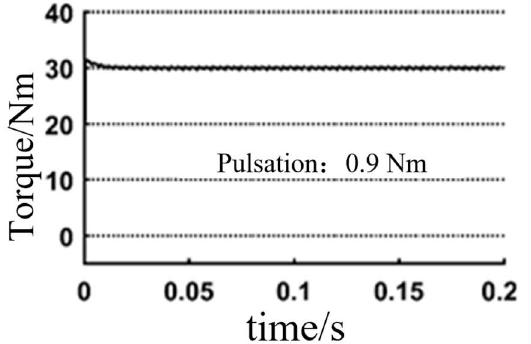
Figure 6. Simulation results with 30Nm load.